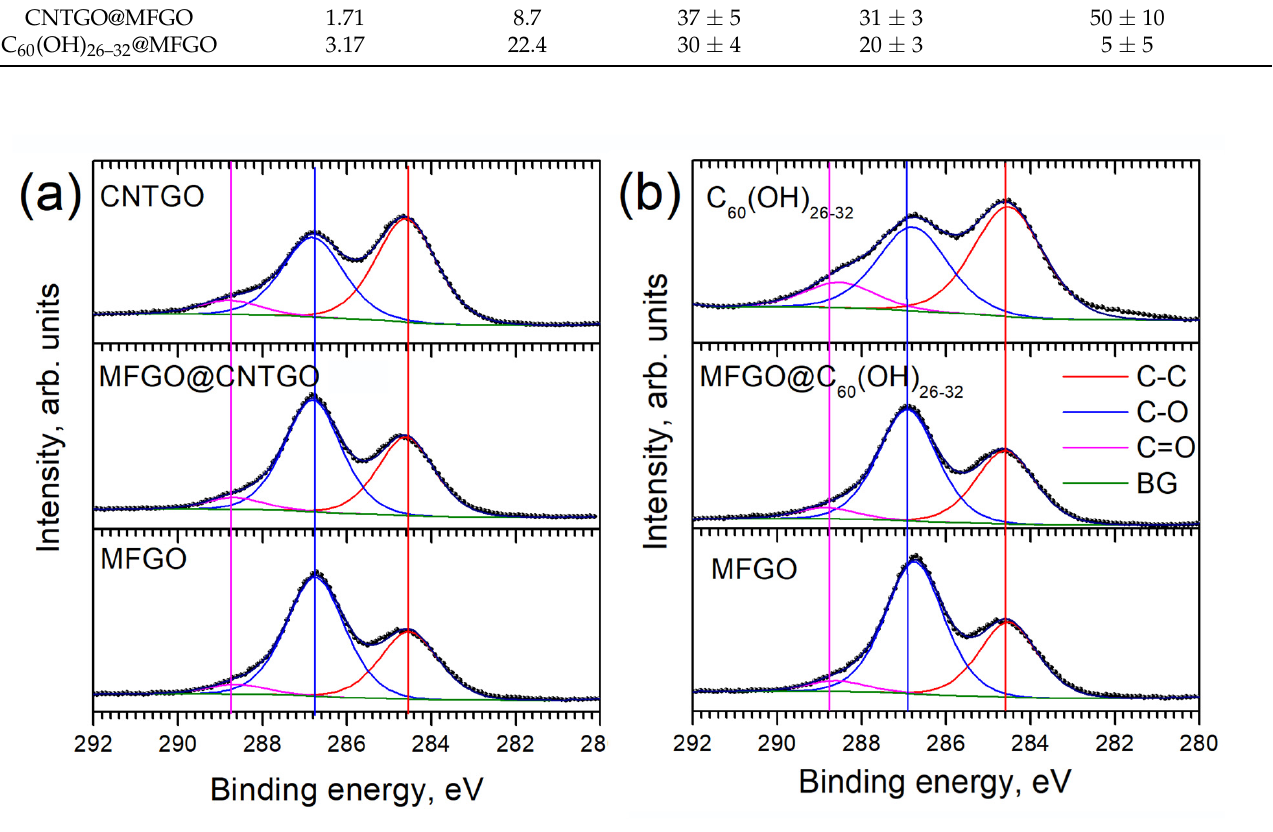
Figure 2. XPS spectra of composite membranes: ( a , b )—C1s-spectra for GO nanoribbons- and fullrenol-intercalated samples, respectively.